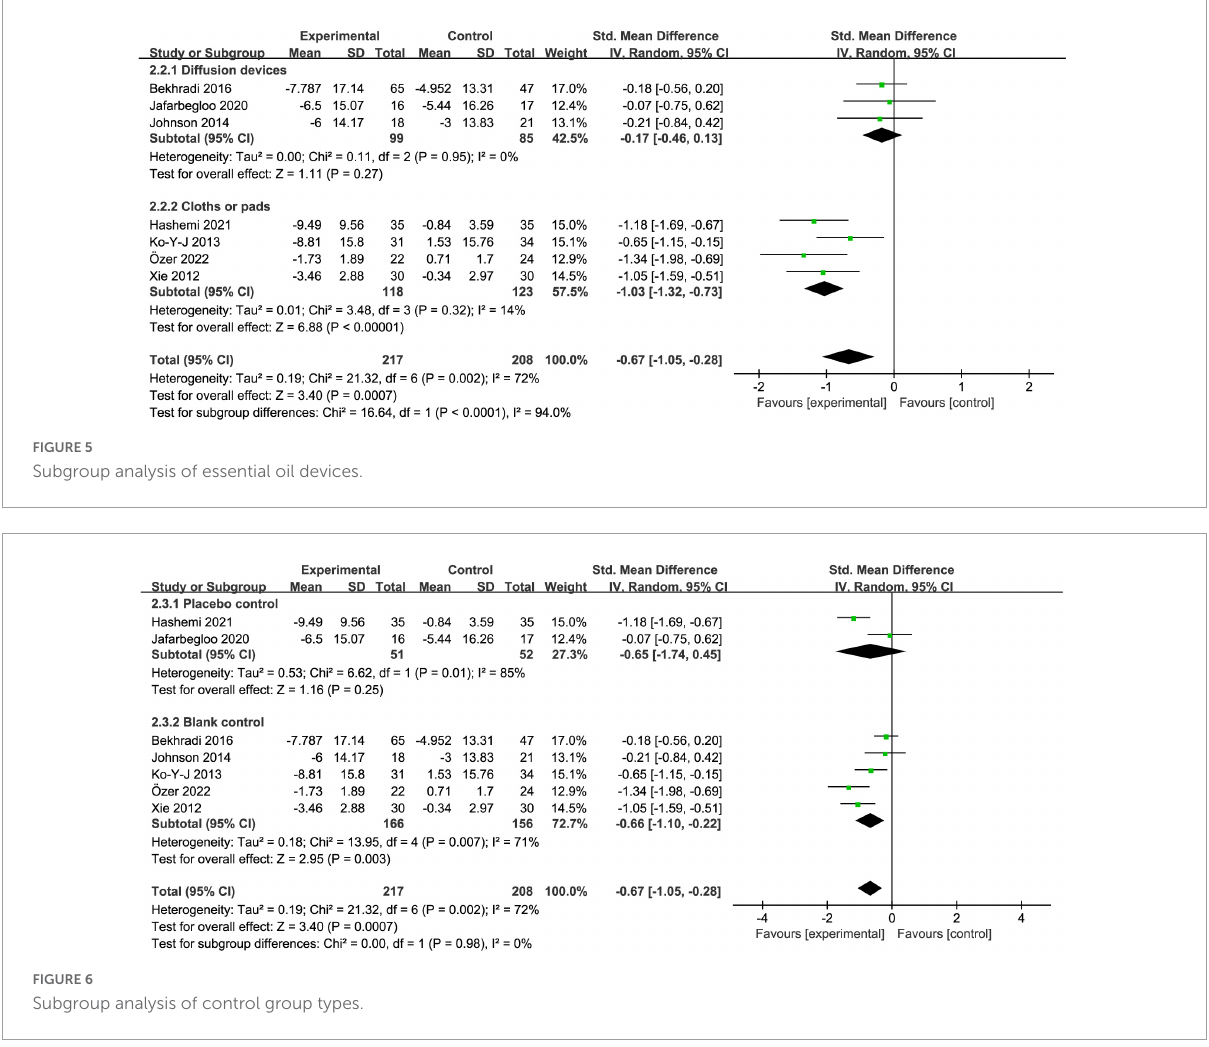
FIGURE6 Subgroup analysis of control group